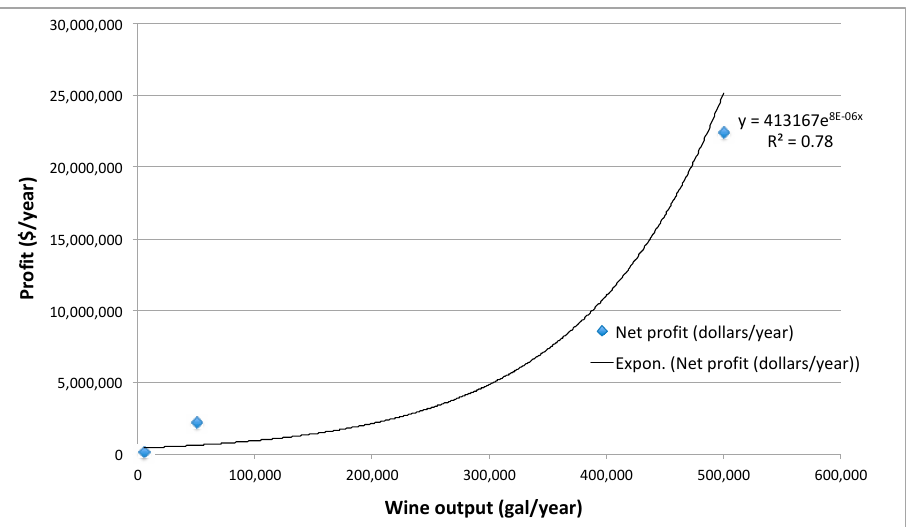
10 of 13 Figure 9. Annual revenues according to scale of operation (showing linear trendline).